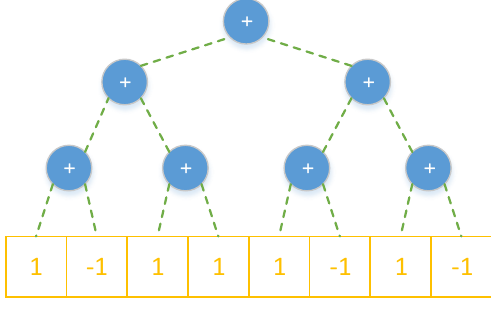
Figure 8. Popcount dichotomy algorithm.